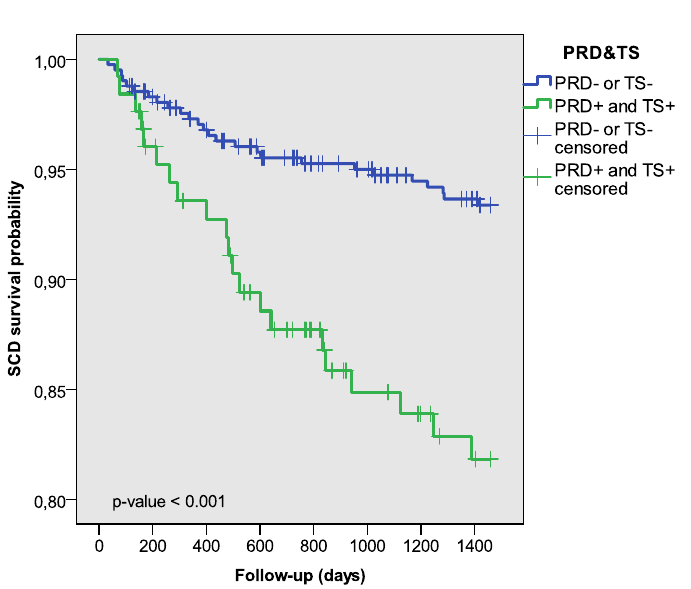
Figure 5. Estimated probability curve of SCD for two subgroups defined by PRD + and TS +